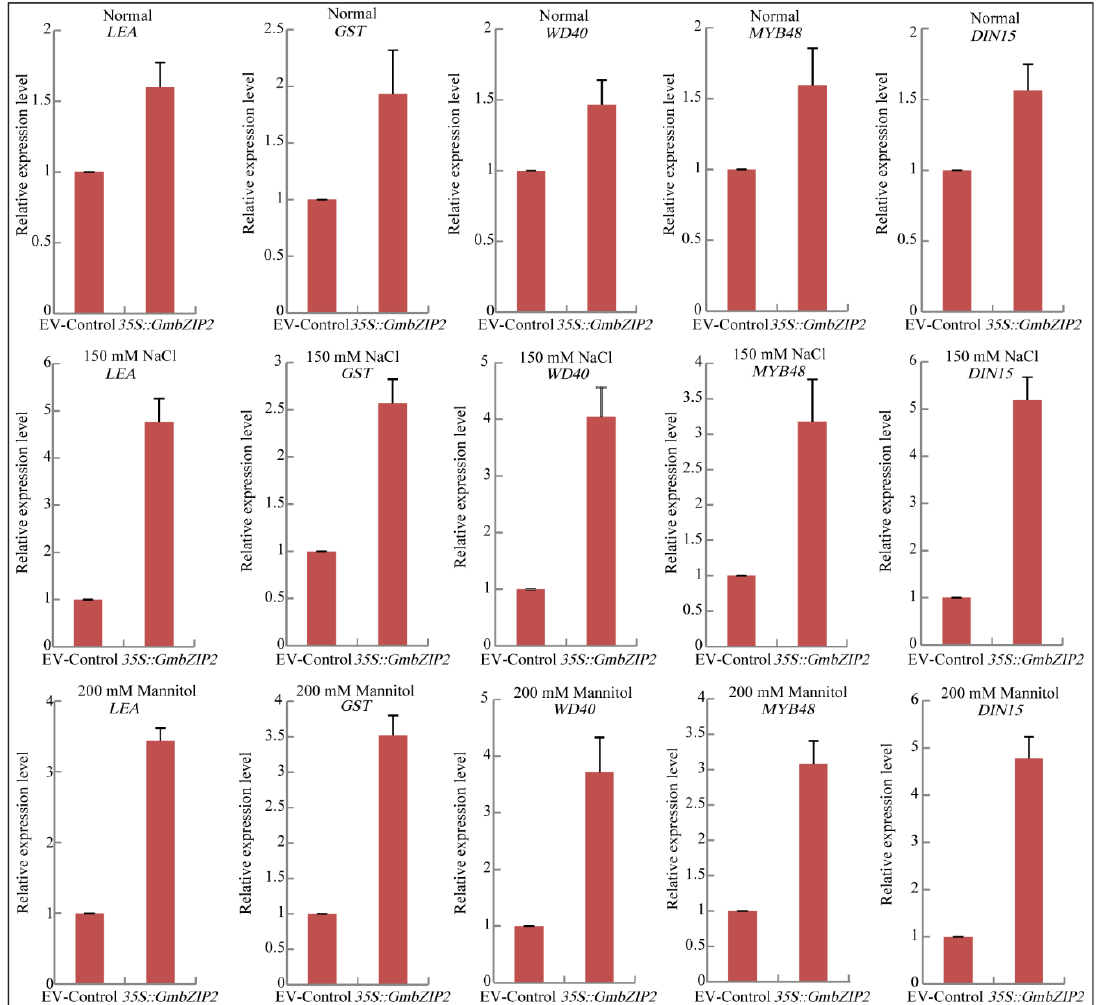
Figure 10. Expressions of five stress-responsive genes in transgenic GmbZIP2 soybean hairy root plants under normal conditions, 150 mM NaCl and 200 mM mannitol treatments detected by qRT-PCR. Vertical bars indicate ± SE of three replicates.